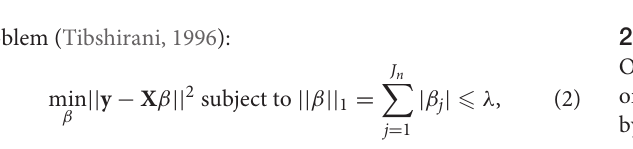
problem (Tibshirani,